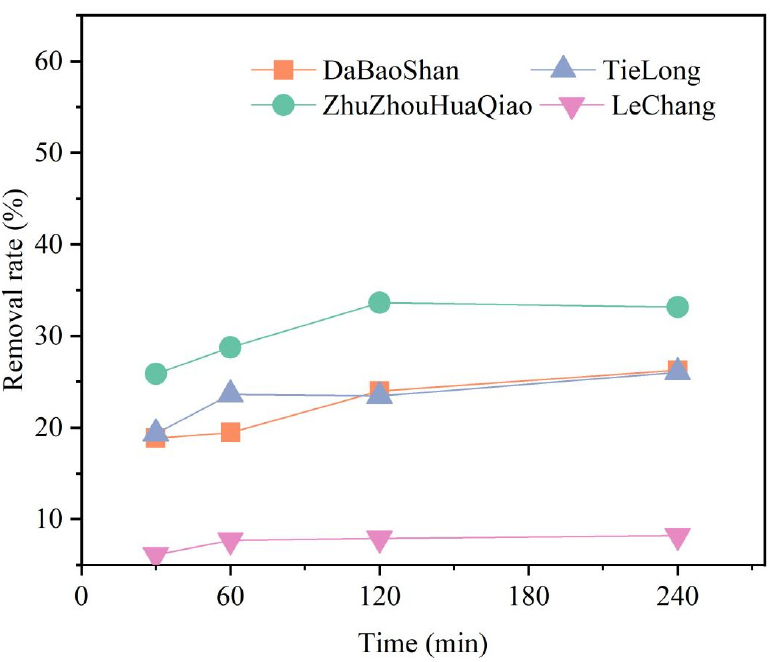
Figure 3. The change in Pb leaching removal rate with time of GLDA-Na with pH 11.13 of 5 mol/L concentration.